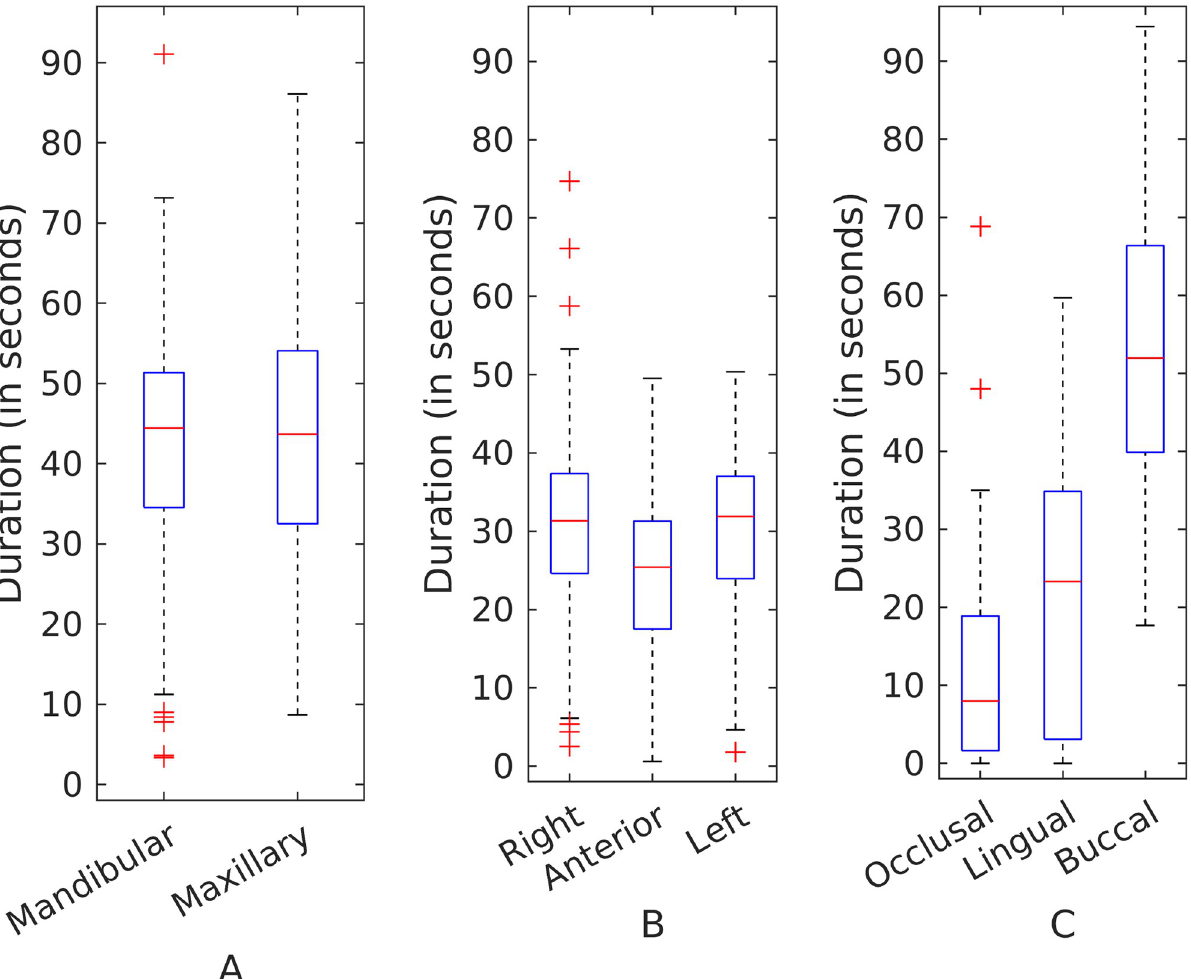
Fig 4. Group-level brushing times of different dental regions. Categorized by (A) jaw, (B) side, and (C) surface. Buccal surfaces were brushed twice more than the lingual and occlusal surfaces.